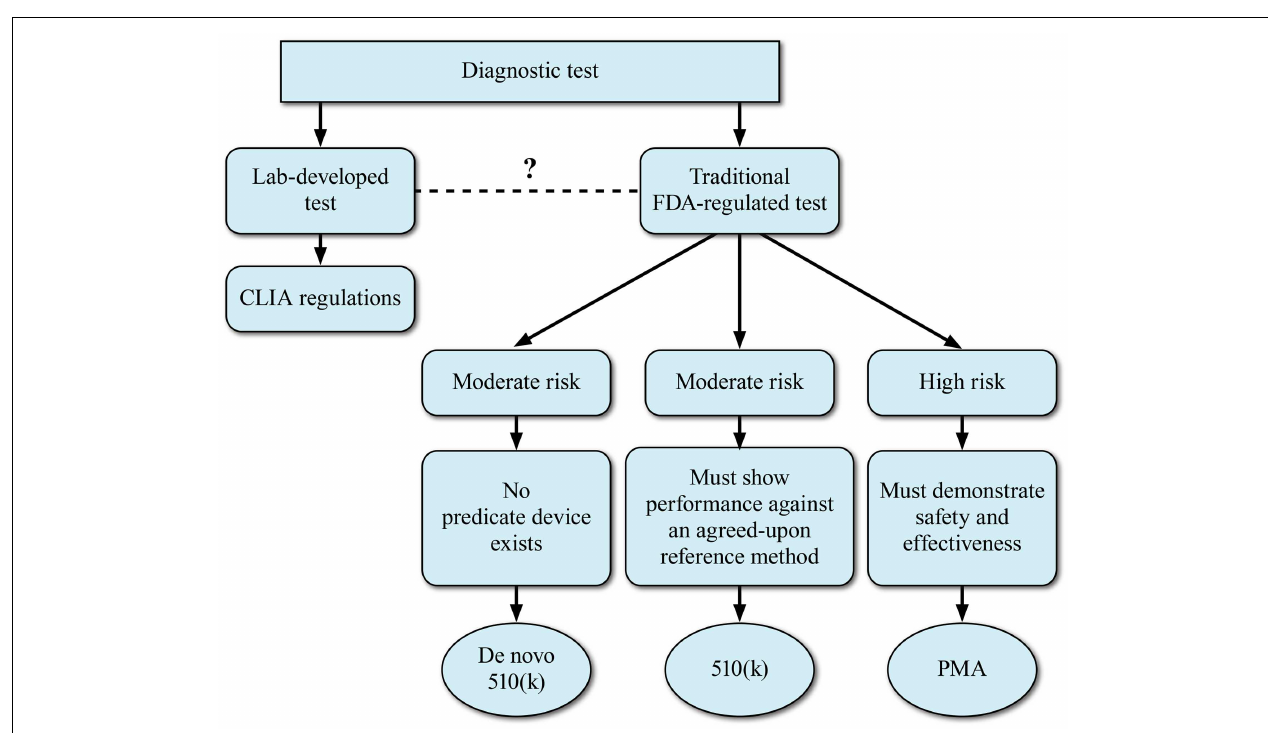
FIGURE 3 | Regulatory models for development of NGS-based diagnostics .The FDA device classification for a regulated NGS-based diagnostic device will depend on the perceived risk associated with the diagnostic